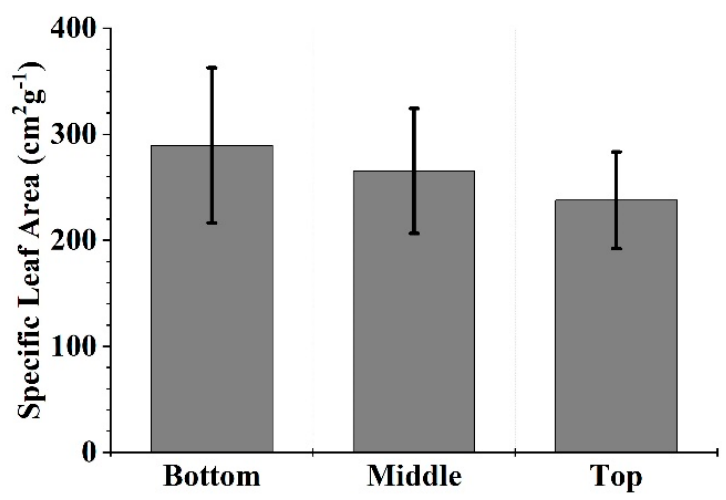
Figure 3. The average specific leaf area (cm 2 · g − 1 ) of the 29 Moso bamboo crowns in the top, middle, and bottom sections, respectively. The error bars represent the mean ± standard deviation.